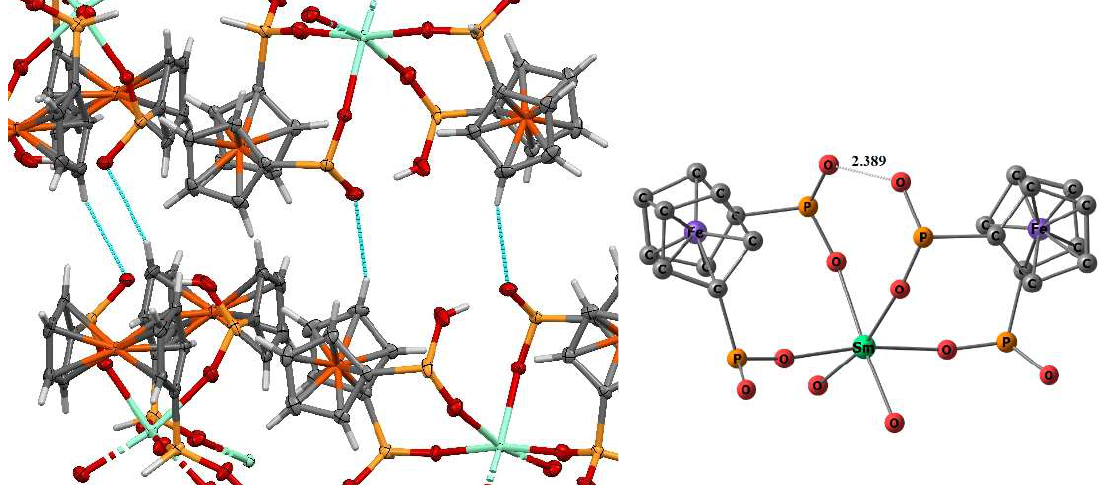
Figure 7. Weak interactions between layers in 2D CP 2 ( left ) and O--O contact ( right ). In addition, for the first time, the Mössbauer effect studies were performed on fer- rocenyl phosphinate 1 and the coordination polymer 2 based on it. Room temperature Mössbauer spectra of both 1 and 2 may be well-fitted with the single doublet component (Figure 8). The hyperfine parameters are listed in Table 1. The center shift values of these compounds are almost matching with each other and with the value for ferrocene. It shows that the electron density on 57 Fe is nearly the same. However, a more pronounced effect was observed in the quadrupole splitting (QS) values. The QS for 2 is less than for both 1 and ferrocene.